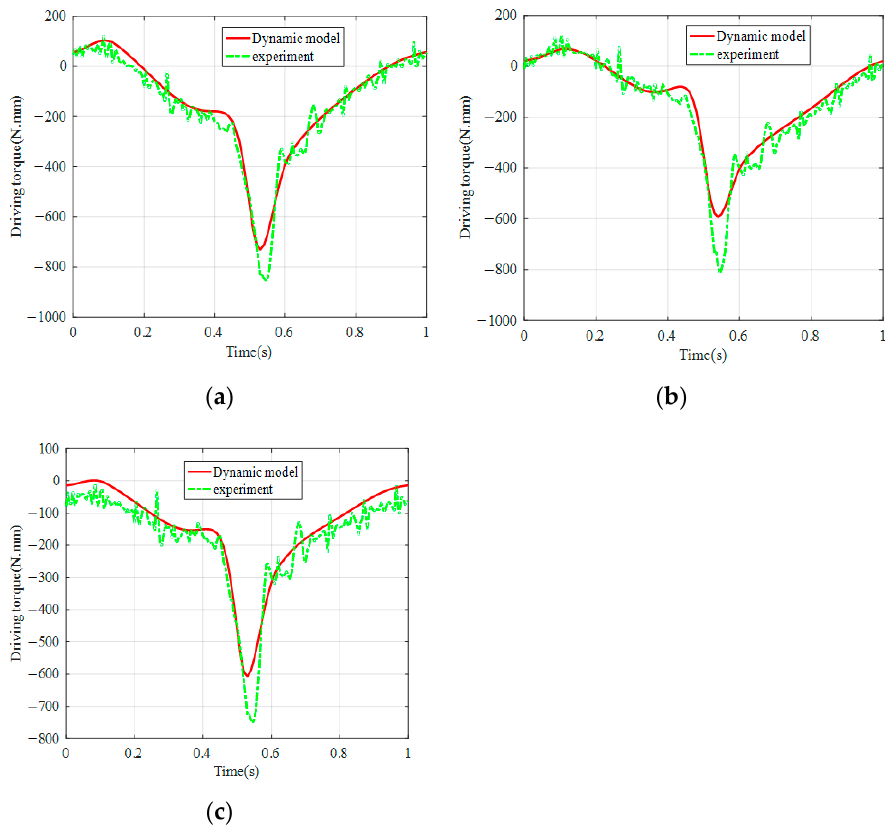
Figure 11. Torques actuated by the motors. ( a ) Linear module 1; ( b ) Linear module 2; ( c ) Linear module 3. module